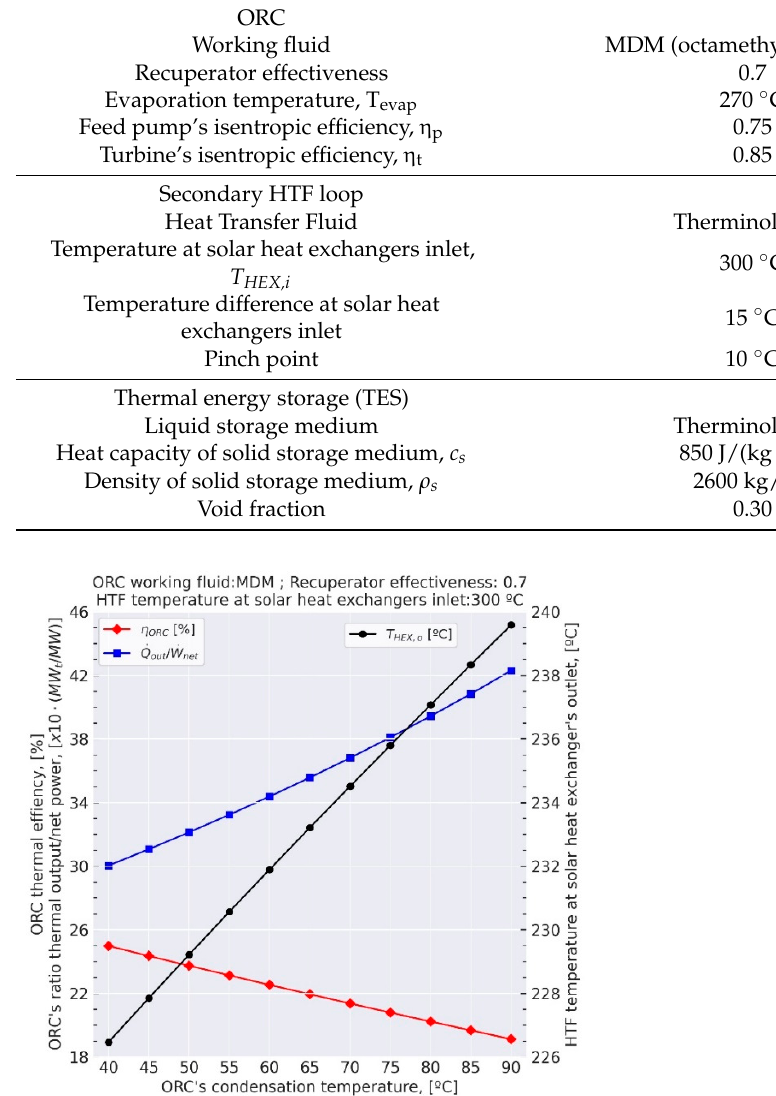
Table 2. Information used to compute the ORC’s performance, HTF-ORC heat exchange processes, and basic sizing of the TES.